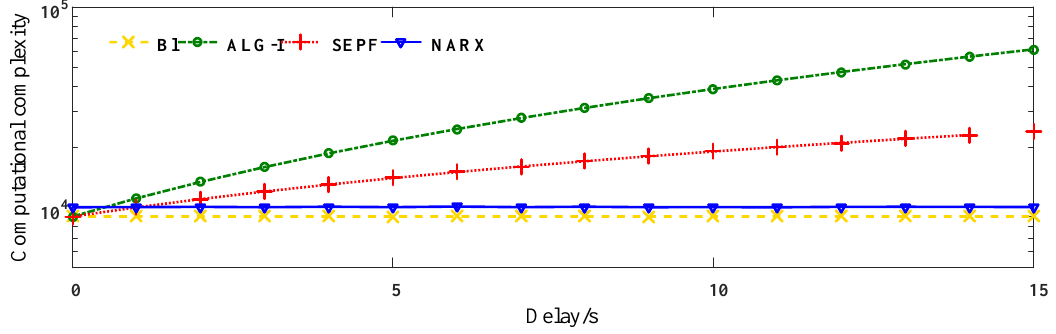
Figure 7. The computational complexity of OOSM methods: Bl, ALG-I, SEPF and NARX based algorithms. The delay of inputs is 5, the computational complexity is represented by the float